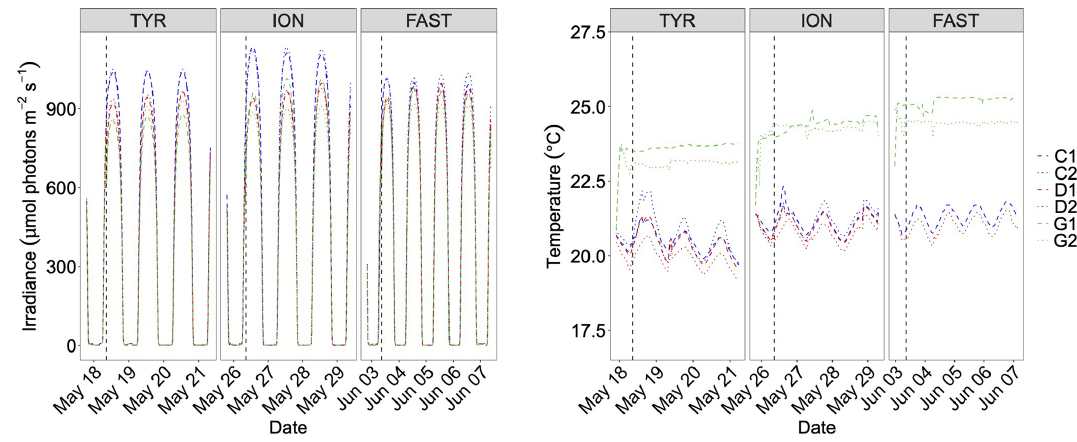
Figure 4. Continuous measurements of temperature and irradiance level (PAR) in the six tanks during the experiments at TYR, ION and FAST. The dashed vertical line indicates the time of dust seeding (after t0).